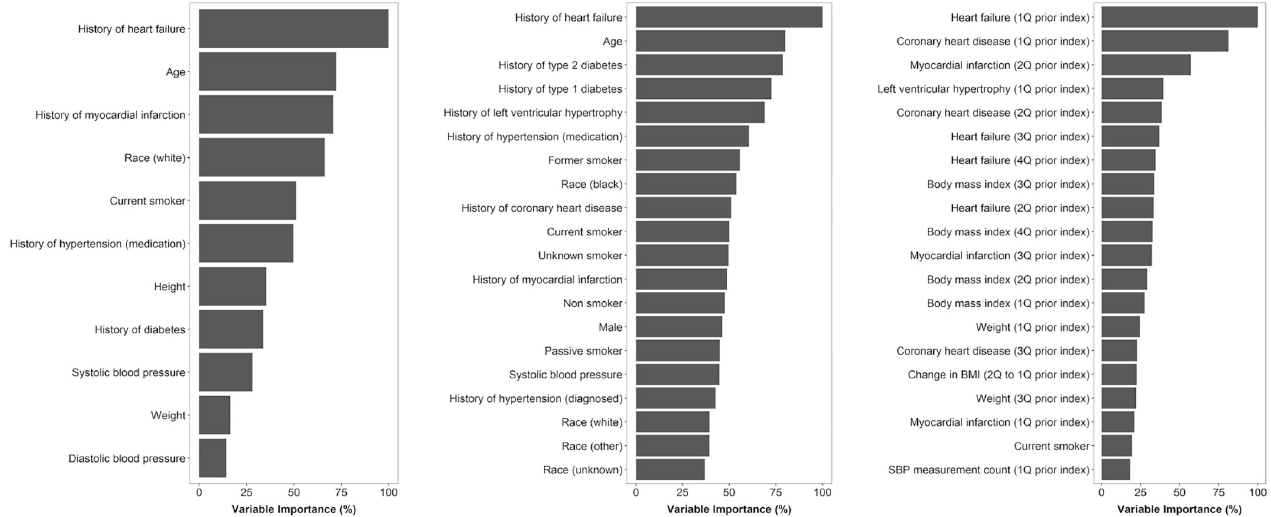
Fig 1. Most important predictors of AF according to: (A) the CHARGE-AF risk model; (B) the fitted baseline neural network; and (C) the fitted time- varying neural network. Variable importance was determined on the training dataset according to the absolute size of the published regression coefficients for the CHARGE-AF risk model[11] and Garson’s algorithm[23] for the fitted neural networks. Importance is expressed as a percentage of the most important predictor within each model. Importance is shown for all 11 variables in the CHARGE-AF risk model and the top 20 most important variables in each of the fitted neural network models.